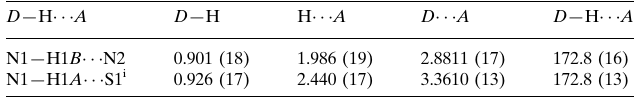
Hydrogen-bond geometry (A˚ , (cid:4)